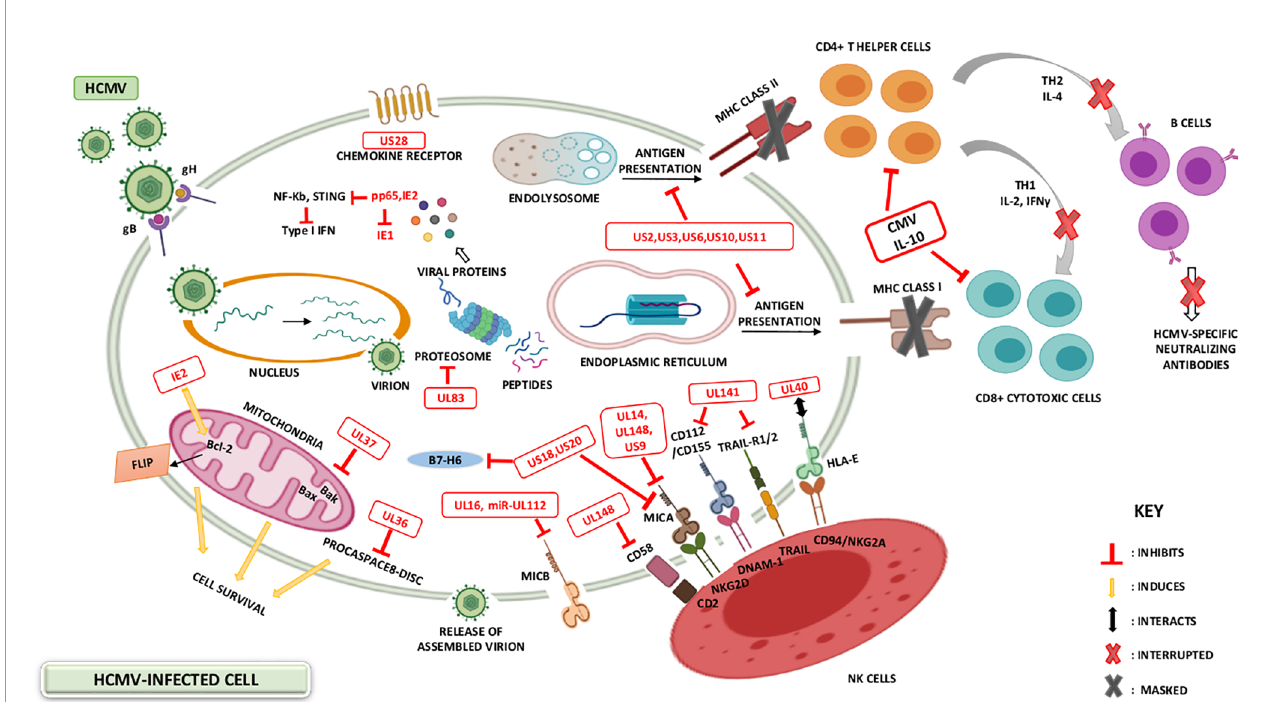
FIGURE 1 | HCMV-induced modulation of the host immune system. The battle between the host immunity and HCMV is permanent, with HCMV developing various mechanisms to evade the host immune system. Immunosuppression may be ascribed to the variety of immune modulators encoded by HCMV-speci fi c gene products. HCMV viral genes prevent MHC Class I and II antigen presentation and thus interfere with interferon responses, NK cell recognition as well as CD4 + and CD8 + T-cell recognition. Additional HCMV genes for instance IL-10 homologue (UL111a), and viral proteins acting as receptors for host in fl ammatory cytokines (US28), further suppress the host immune